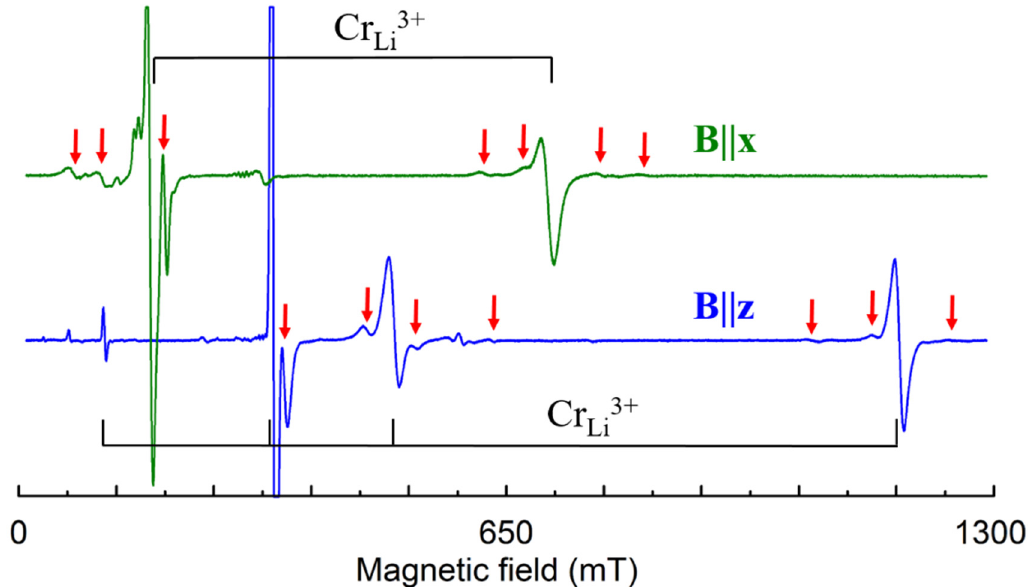
Figure 13. Measured EPR spectrum of Cr 3+ in LN grown from the melt with x m ≈ 60% and 0.1 wt.% of Cr (room temperature, ν = 9.84 GHz). Black braces indicate lines of dominant Cr 3+ center, red arrows—lines of satellite centers.